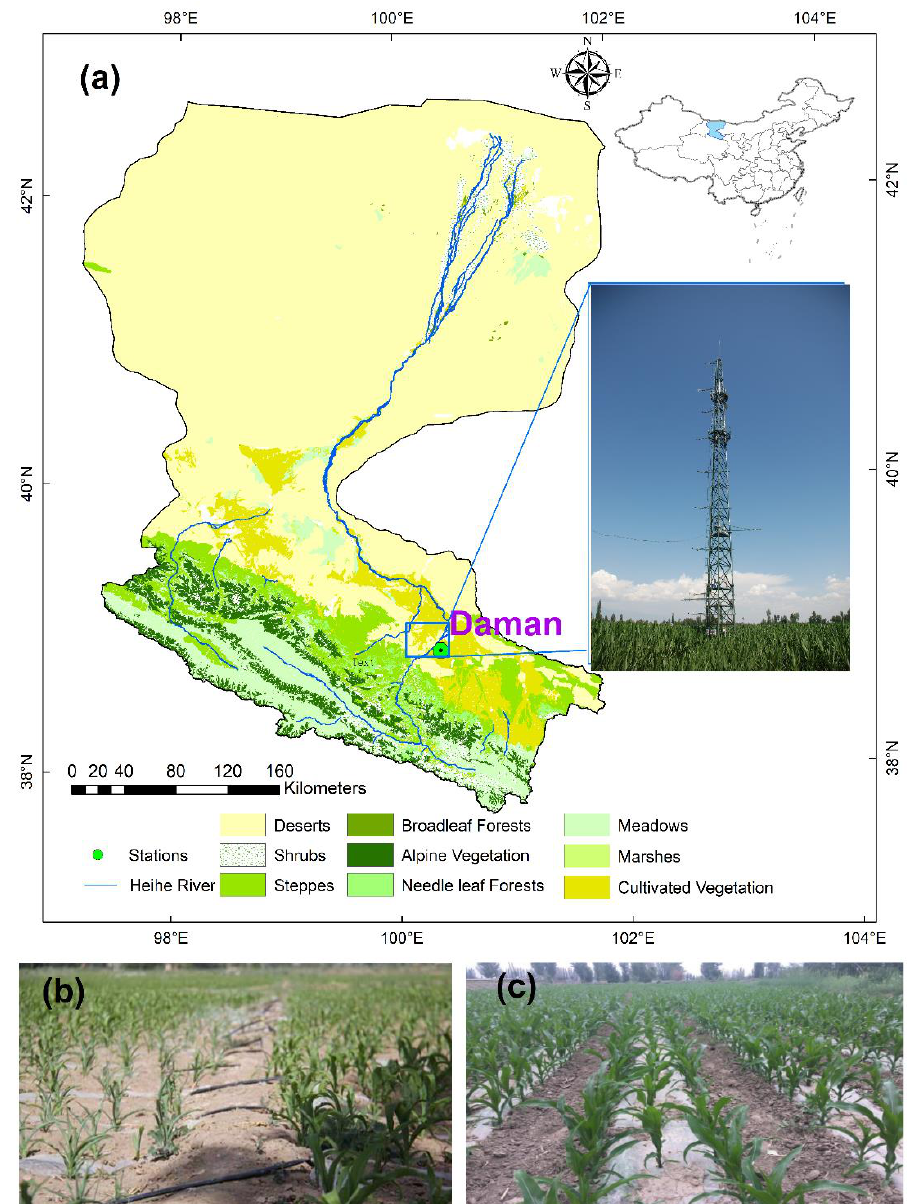
Figure 1. Location of the study site (Daman) in the Heihe River Basin (HRB) and in the North-Western China. The right figure shows the flux tower measurement in the Daman ( a ). The below figures show drip irrigation under mulch film ( b , c ).